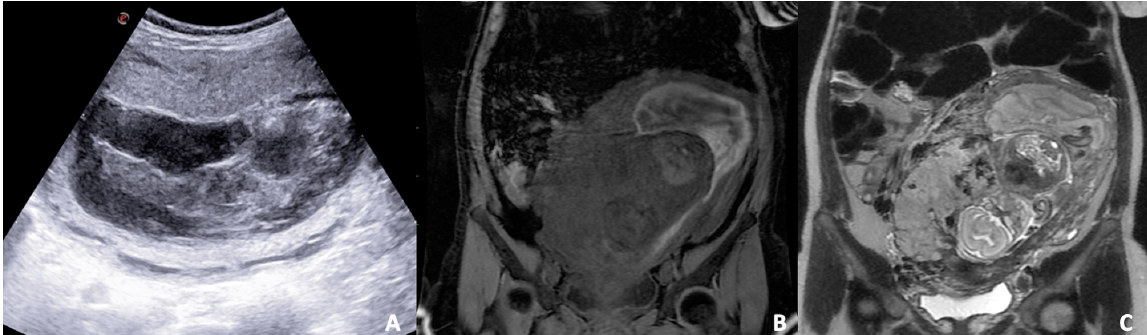
Figure 3. B-mode US scan ( A ) and T1 LAVA ( B ) and T2 FSE ( C ) coronal images of a pregnant woman. ( A ) US reveals a severe change of placental structure with inhomogeneous placental thickening. ( B , C ) MRI sequences show the separation of the placenta from the myometrium in the uterus due to blood accumulation and compression on the uterine wall away from the placenta; a subchorionic hematoma (localised between the chorionic membrane and uterine wall) is diagnosed.